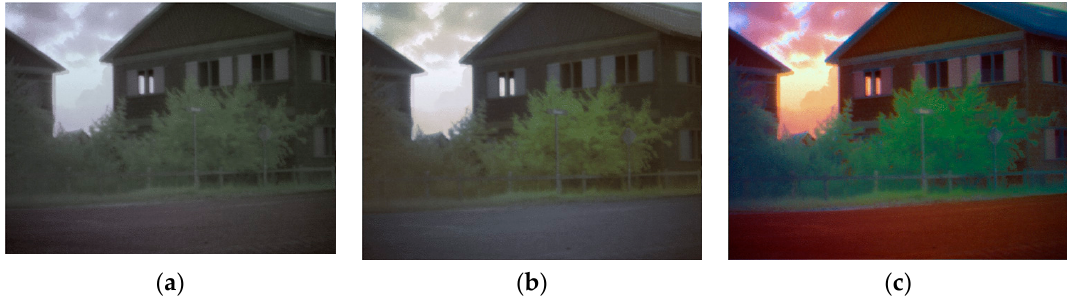
Figure 9. Results of ( a ) an affine fit-transform; ( b ) a 2nd order polynomial fit; and ( c ) a R3DF transformation fit.